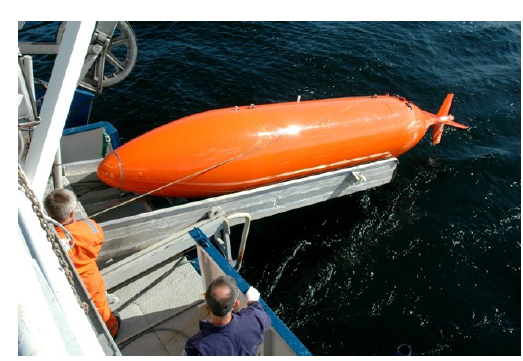
Figure 4: The HUGIN 4500 AUV during sea-trial.